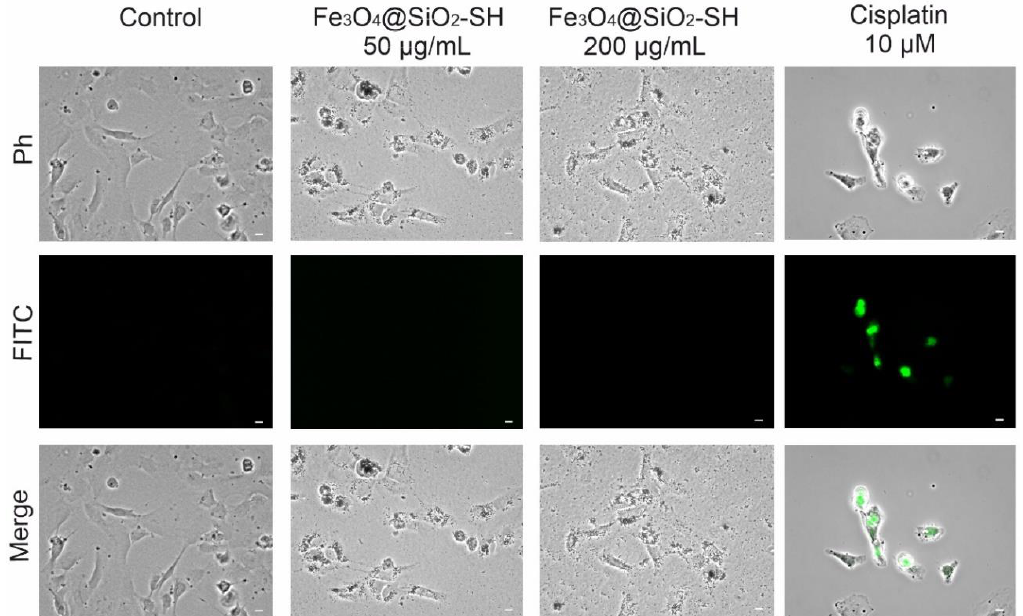
Figure 11. Microscopic study of the activation of caspase-3/7 in A549 cells. The cells were exposed to Fe 3 O 4 @SiO 2 -SH nanoparticles at 50 and 200 µg/mL for 24 h. The images showed apoptotic signals of a CellEvent™ Caspase -3/7 Green Detection Reagent (apoptotic cells, green, FITC), corresponding optical phase-contrast microscopy (Ph), and merged images (Merge). Cells sham-treated with H 2 O (negative control) were used as a negative control, whereas cells treated with 10 µ M cisplatin represented the positive control. Photographs are representative pictures from three independent experiments. The scale bar in the images represents 10 µ